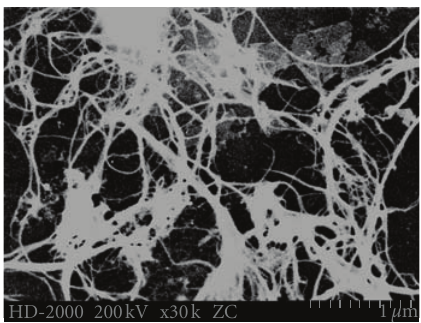
Figure 2: Transmission electron micrograph (TEM) of wood nano-